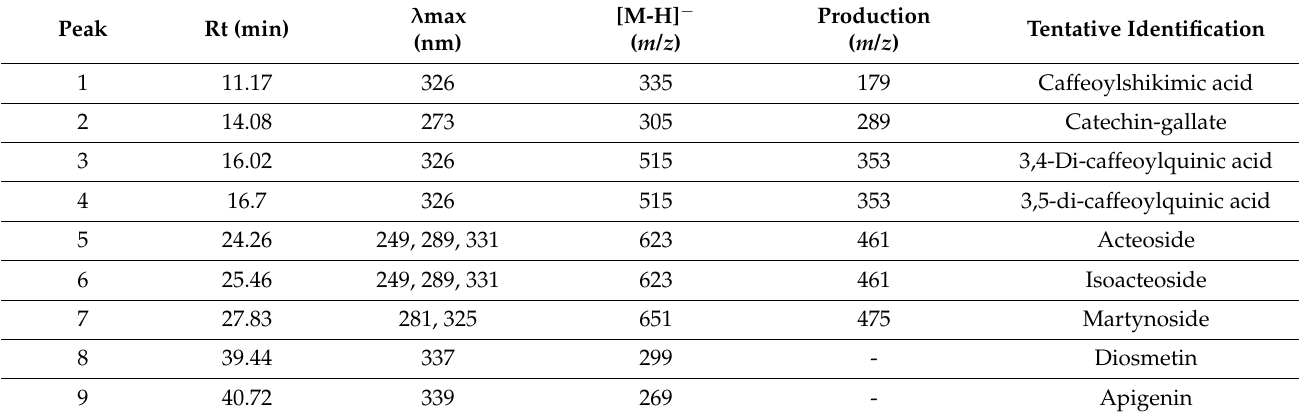
Peak 8 (Rt 39.44 min) showed a characteristic UV spectrum of flavone ( λ max , 337 nm), exhibited a deprotonated molecular ion [M-H] − at m / z 299 and was tentatively identified as diosmetin. Peak 9 (Rt 40.72 min; λ max , 339 nm) showed similar mass spectral data ([M-H] − at m / z 299) to that observed for the commercial standard apigenin. Table 2. Retention time (Rt), spectral data and tentative identification of methanolic lemon verbena extract. Peak